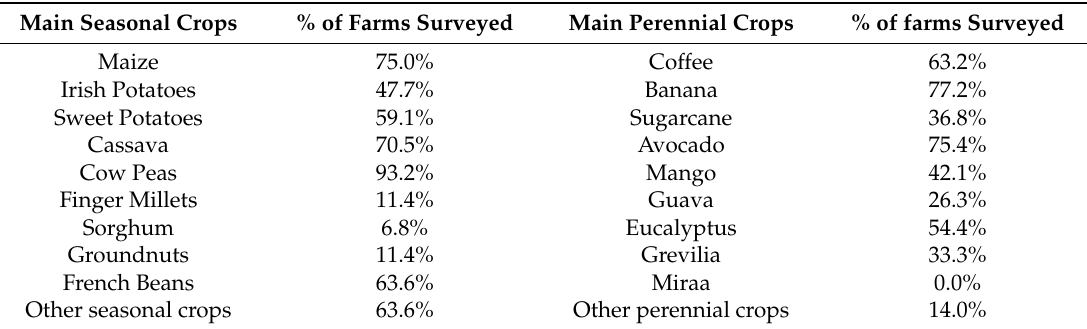
Table 4. Cropping patterns in Muooni